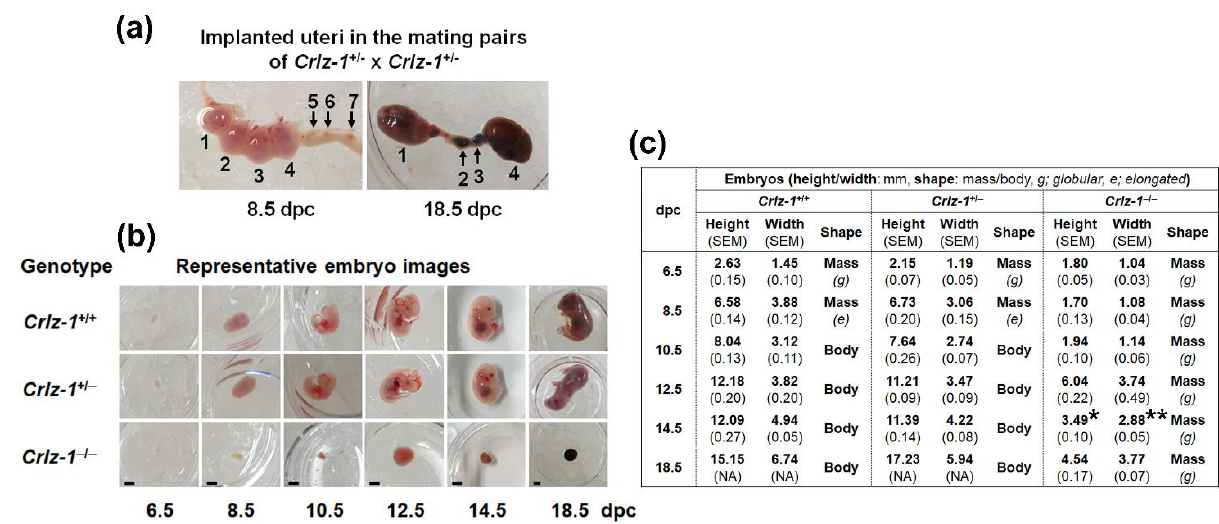
Figure 4. Crlz-1 −/− homozygous null KO mouse embryos were found to be lethally impaired in their development from around 8.5 dpc and evidently so at the later dpc. ( a ) The 8.5 (10× magnification) and 18.5 (4×) dpc images of uteri implanted with embryos of all three different genotypes from the mating pairs of heterozygous KO mice by themselves are shown. The implanted embryos are num- bered for matching them to their genotypes as follows: for 8.5 dpc — Crlz-1 +/+ (#2), Crlz-1 +/ − (#1, 3, 4), and Crlz-1 − / − (#5, 6, 7); and for 18.5 dpc — Crlz-1 +/+ (#4), Crlz-1 +/ − (#1), and Crlz-1 − / − (#2, 3). ( b ) The rep- resentative images of Crlz-1 +/+ wild-type, Crlz-1 +/ − heterozygous KO and Crlz-1 − / − homozygous KO embryos at the various dpc are shown. In the normal control case of wild-type mice, the embryos at the early stages of 6.5 – 8.5 dpc were just a globular or an elongated mass of different sizes (observed with 20×), whereas the embryos at the late stages of 10.5 – 14.5 (10×) and 18.5 dpc (4×) had more or less a body shape. Scale bars: 2 mm. ( c ) The embryos of Crlz-1 wild-type, heterozygous, and homozygous KO mice at various dpc are summarized in a table in terms of height, width, and shape, describing them as a globular or elongated mass and/or a body shape. Height: distance between brain top and hip bottom; width: distance between dorsal and ventral sides. At 14.5 dpc, * p ≤ 2.2 × 10 − 10 for homozygous versus wild-type and * p ≤ 3.5 × 10 − 16 for homozygous versus heterozygous; ** p ≤ 9.2 × 10 − 12 for homozygous versus wild-type and ** p ≤ 1.7 × 10 − 7 for homozygous versus heterozygous. NA: not applicable, SEM: standard error of the